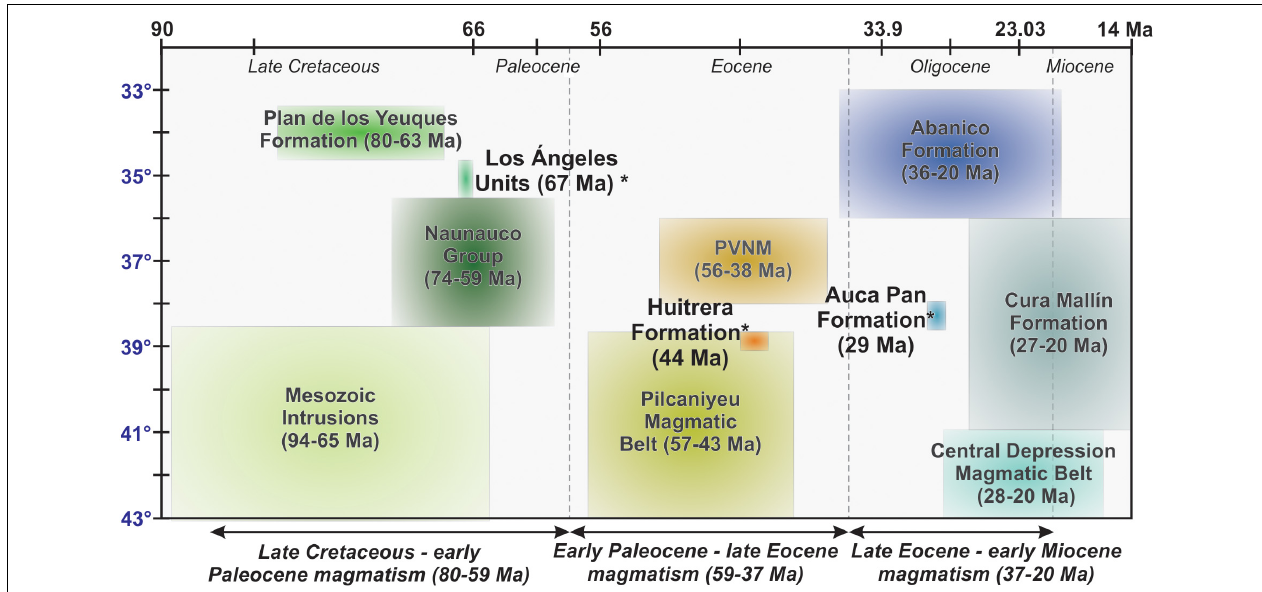
FIGURE 6 | Schematic diagram showing the main arc-related units used in the regional comparison. Geochemical data area from the following: for the first magmatic period (80–59 Ma): Casé et al. (2008); De La Fuente (2014), Franchini et al. (2003); Iannelli et al. (2018), Llambías and Aragón (2011); Lucassen et al. (2004), Mateo-Fernández Caso et al. (2011); Muñoz et al. (2018), and Zamora Valcarce et al. (2006); for the second magmatic period (59–37 Ma): Aragón et al. (2011); Iannelli et al. (2017), Kay et al. (2006), and Llambías and Rapela (1989); and for the last period (37–20 Ma): Iannelli et al. (2017); Kay et al. (2005)Kay et al. (2006); López-Escobar and Vergara (1997), Piquer et al. (2017), and Utgé et al.